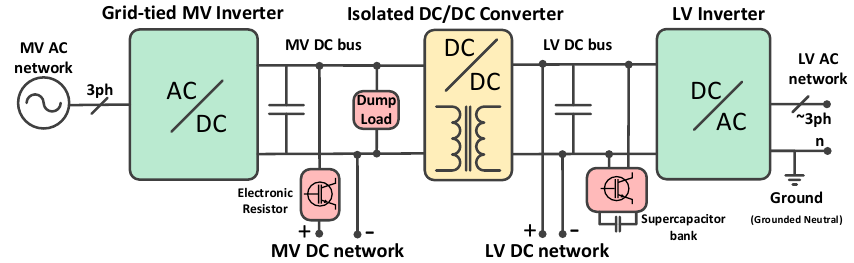
Figure 2. Overall structure of the computational model developed for the Smart Transformer.